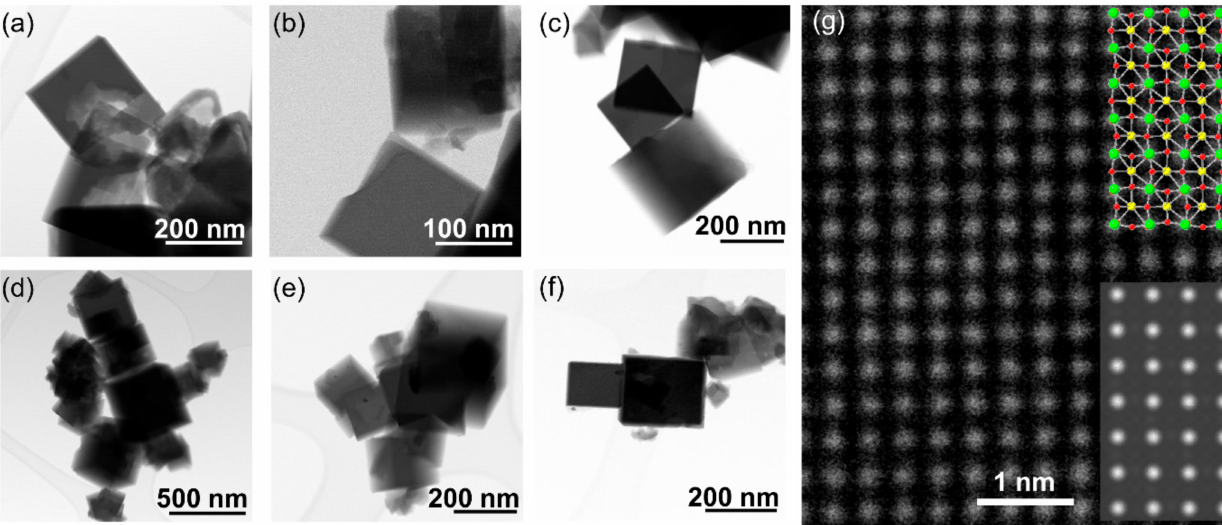
Figure 3. TEM images of Ir-substituted NaTaO 3 materials with intended Ir content of ( a ) 0%, ( b ) 10%, ( c ) 20%, ( d ) 30%, ( e ) 40% and ( f ) 50%. See Supporting Information for further images of the specimens. ( g ) shows a high-resolution TEM image of the 40% Ir material, with the simulated image (lower inset) and the corresponding crystal structure (upper inset, where green atoms are Ta(Ir), yellow are sodium, and red are